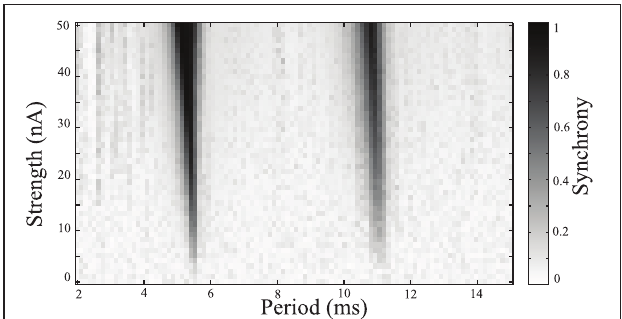
FIGURE 4 | Synchrony map of stimulated tonic networks. Current input of 6nA applied to all cells. Grayscale indicates calculated synchrony as the Kuramoto order parameter averaged over the last 200ms of individual simulation for a range of stimulus amplitudes and periods.